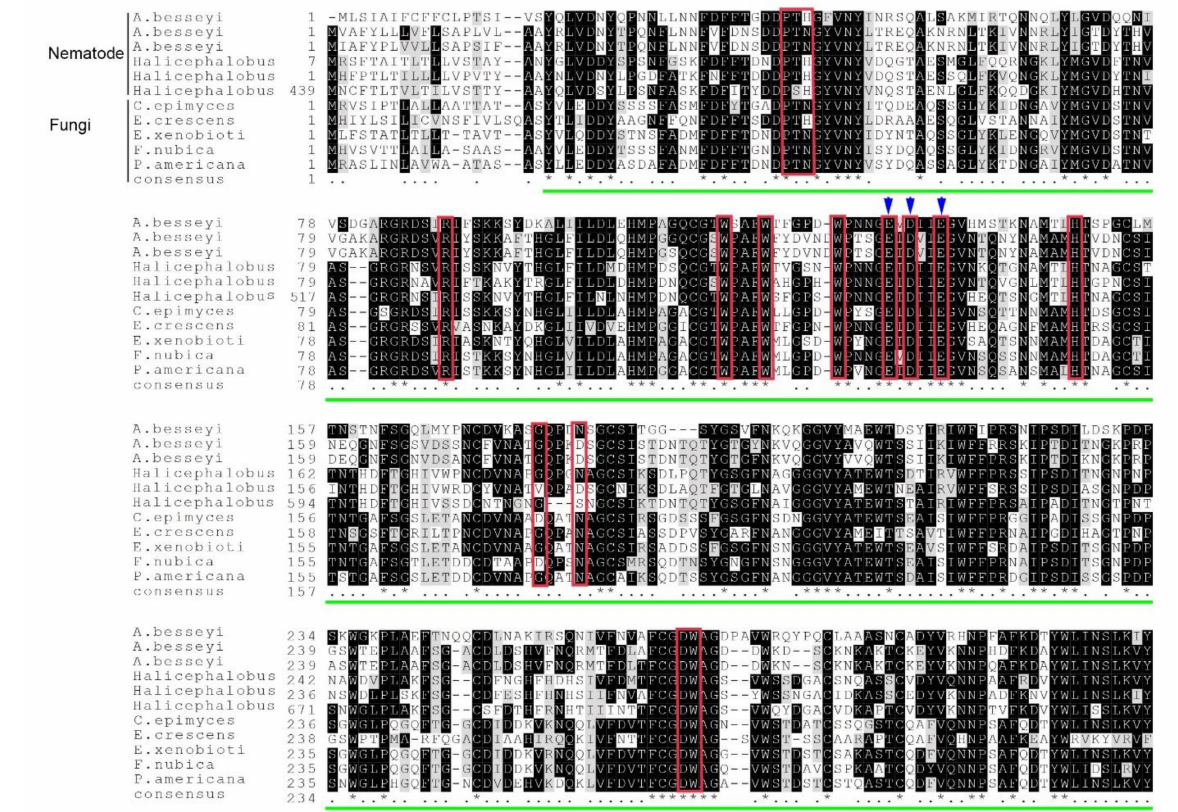
Figure 2. Multiple sequence alignment of the predicted AbGH16 protein with other GH16 proteins. Six nematode GH16 proteins in Aphelenchoides besseyi isolates NJ (AbGH16-1; AWH98111), R1 (AbGH16-2, ARD05880), and Fm (ARD05881), and in Halicephalobus sp. (KAE9549822, KAE9555931, KAE9549822, and five GH16s in the fungal species including Capronia epimyces (XP_016224388), Emmonsia crescens (PGH36908), Exophiala xenobiotica (XP_013314421), Fonsecaea nubica (XP_022496328), Phialophora americana (KIW68755) were aligned by MAFFT. The red box indicates catalytic residues, the blue arrow refers to EXDXXE active sites of GH16 protein, and the green line indicates the LamG